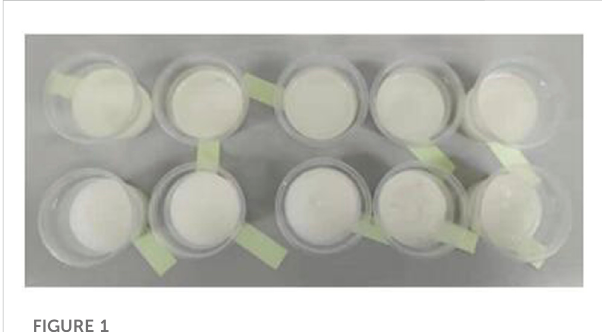
FIGURE 1 Polymer colloid fi re extinguishing agent.